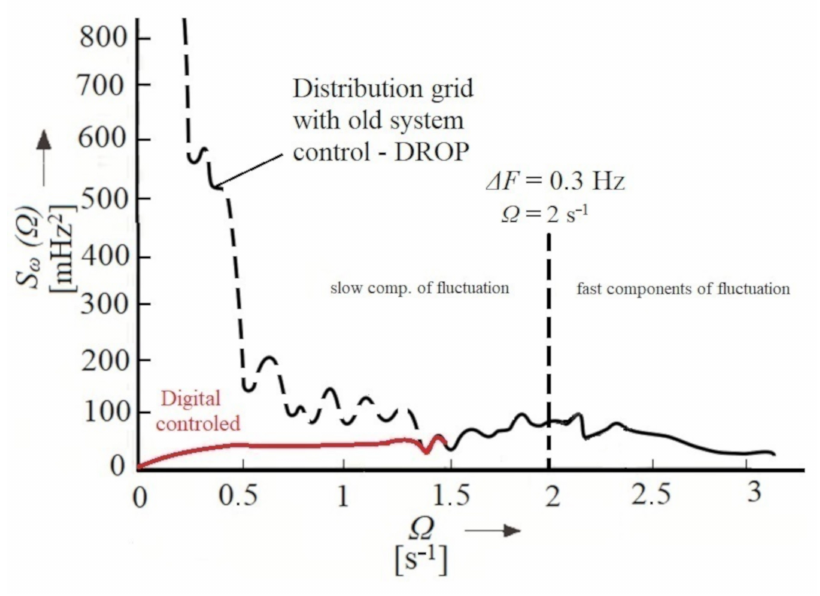
Figure 1. Examples of power spectral density S ω ( Ω ) at frequency fluctuation Ω